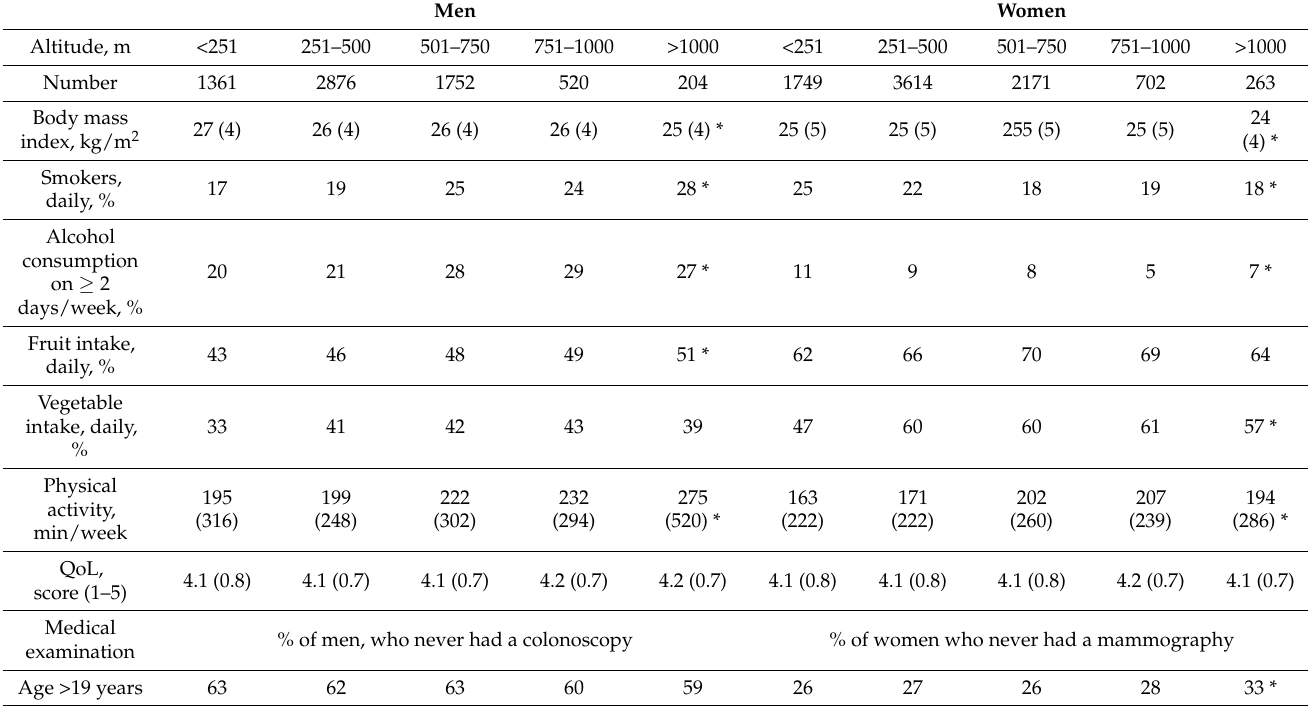
Table 2. The selected results derived from the representative, population-based, health interview survey. Men